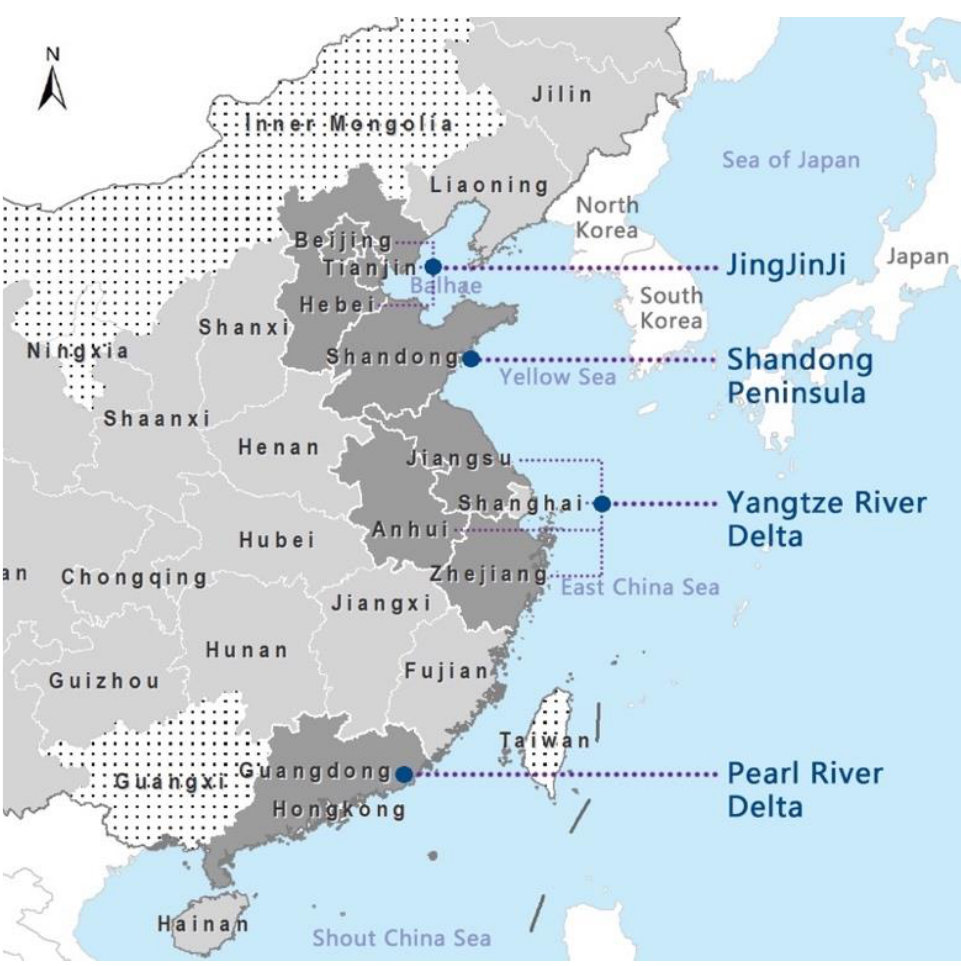
Figure 1. The location of study areas in China.